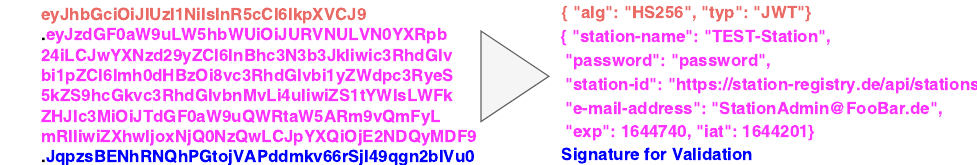
Figure 3. Example of a JWT. In our scenario, we use a JWT to transmit the station on-boarding information. The token consists of a header (orange), the payload (pink), and a signature (blue). The payload includes, for example, the station name and, especially, the one-time-password (OTP), which is later used for the configuration file encryption. The signature is used to validate the integrity of the JWT.